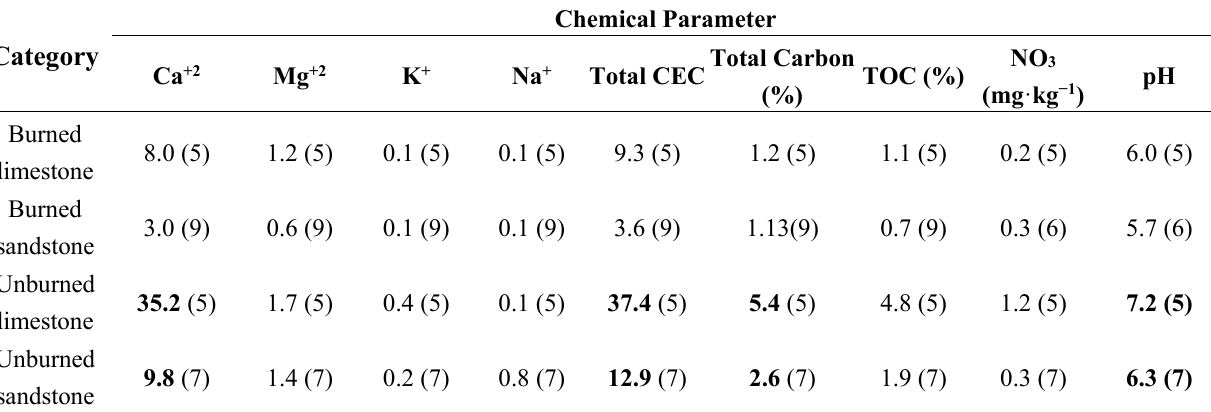
Table 8. Wilcoxon rank sum test results with medians in cmol·kg − 1 for Ca +2 , Mg +2 , K +1 , Na +1 , and Total CEC; medians in percent for Total Carbon and Total Organic Carbon; and medians in mg·kg − 1 for NO 3 ; and sample sizes ( n ) for respective parameters for differences between treatment and geology of the top soil layer (0–25 cm). Values in bold exhibited significant differences in population distributions across geology.